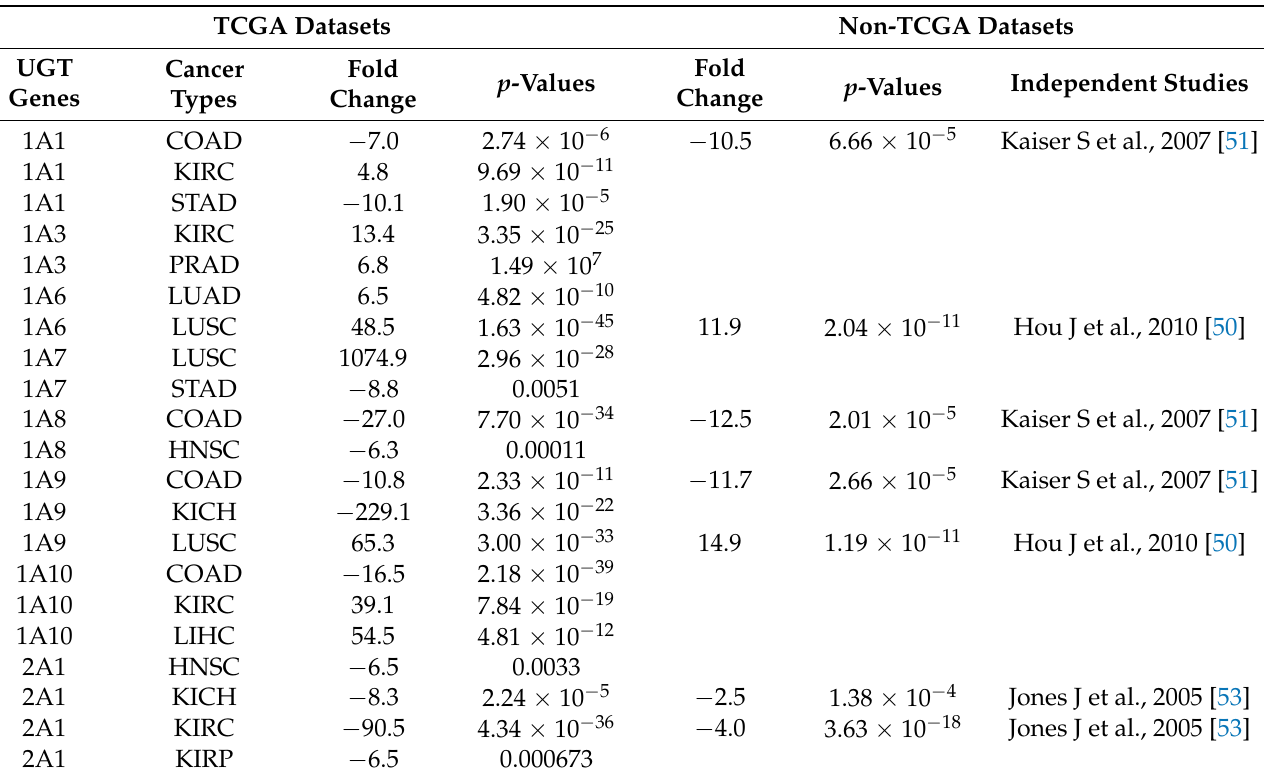
Table 2. UGT genes that were up/downregulated in cancerous tissues compared to matched adjacent non-cancerous tissues in TCGA and non-TCGA cancer datasets. A p -value of <0.01 is considered statistically